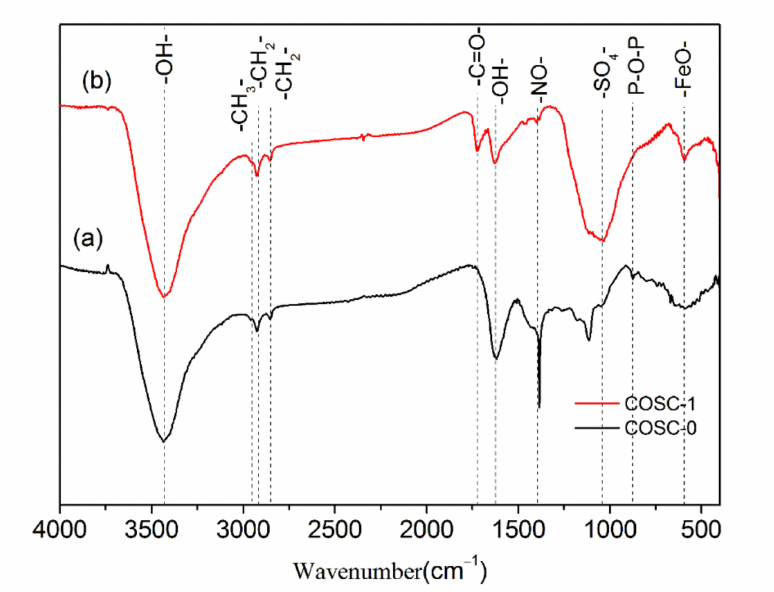
Figure 8. FTIR spectrum of COSC-0 ( a ) and COSC-1 ( b